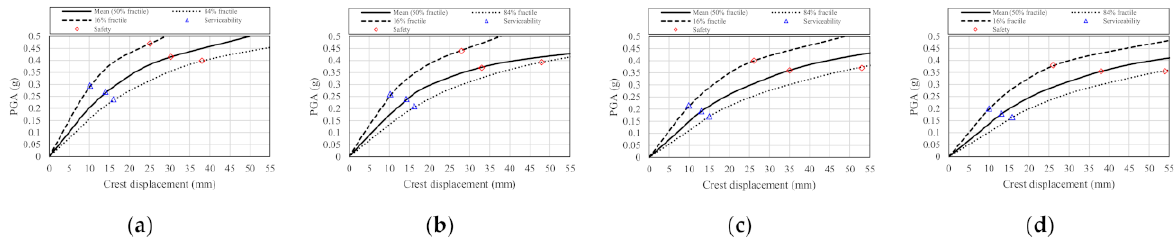
Figure 15. Fractile IDA curves four different age consideration; ( a ) 0 years, ( b ) 25 years, ( c ) 50 years, ( d ) 75